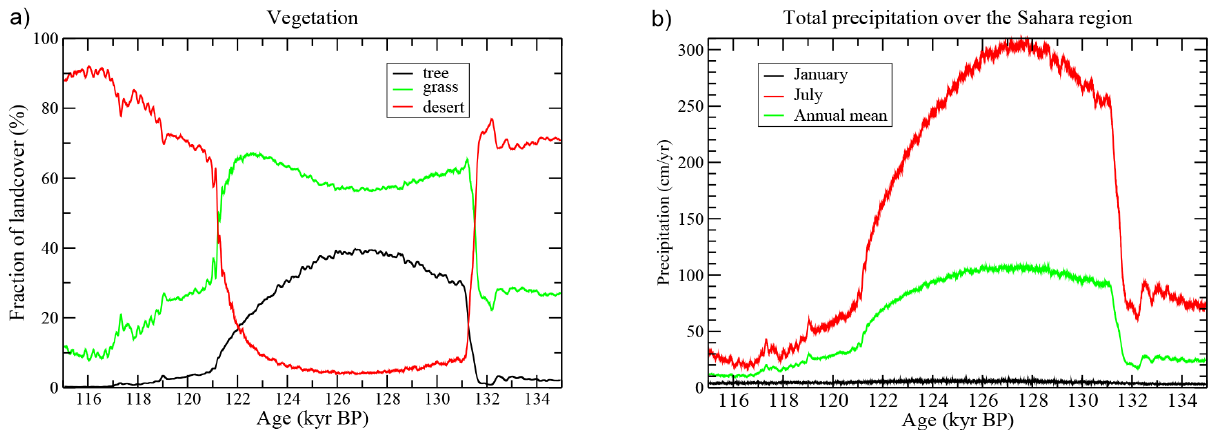
Figure 10. (a) Changes in land cover during the LIG over the Sahara region. (b) Time evolution of precipitation in January, July and in annual mean during the LIG over the Sahara region for simulation allGR.